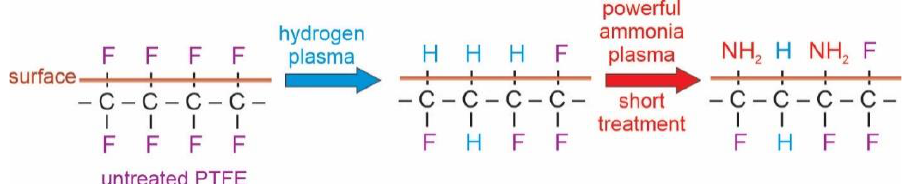
Figure 12. Simplified illustration of the effect of ammonia plasma sustained at the large power and short treatment times.